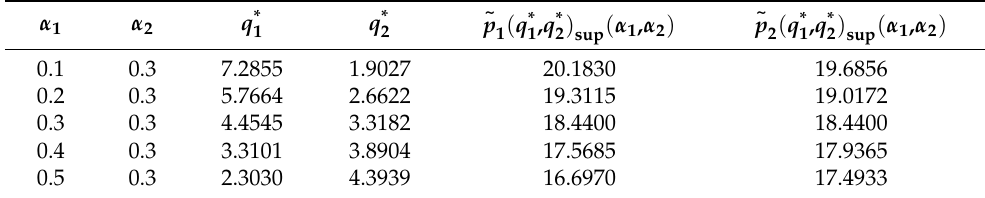
( α 1 , α 2 )-optimistic equilibrium quantity for Scenario I when CDT’s risk aversion levels increase.